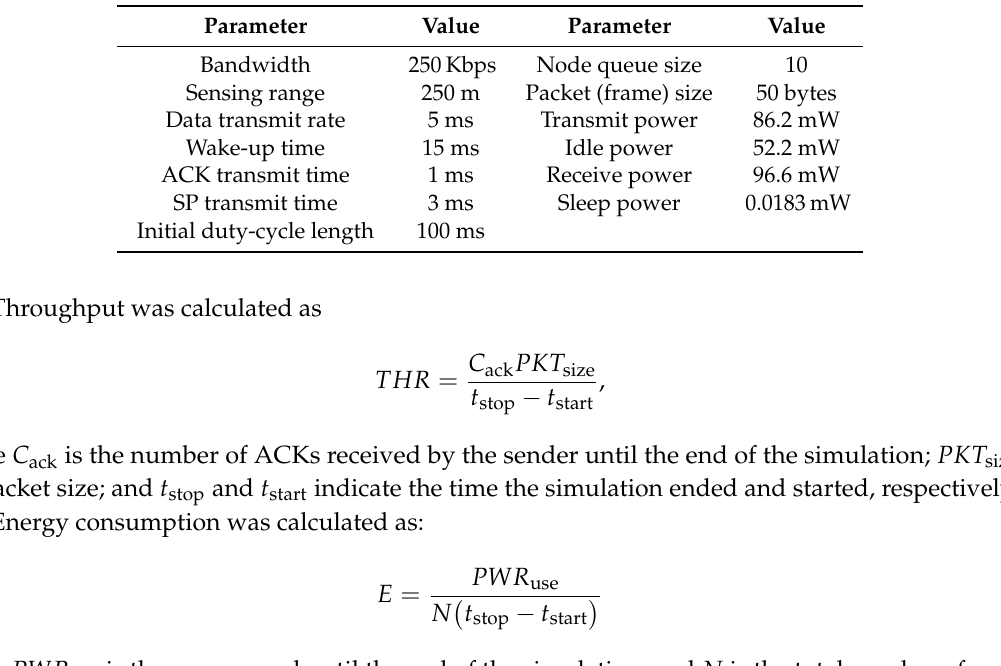
Table 5. Network topology and simulation